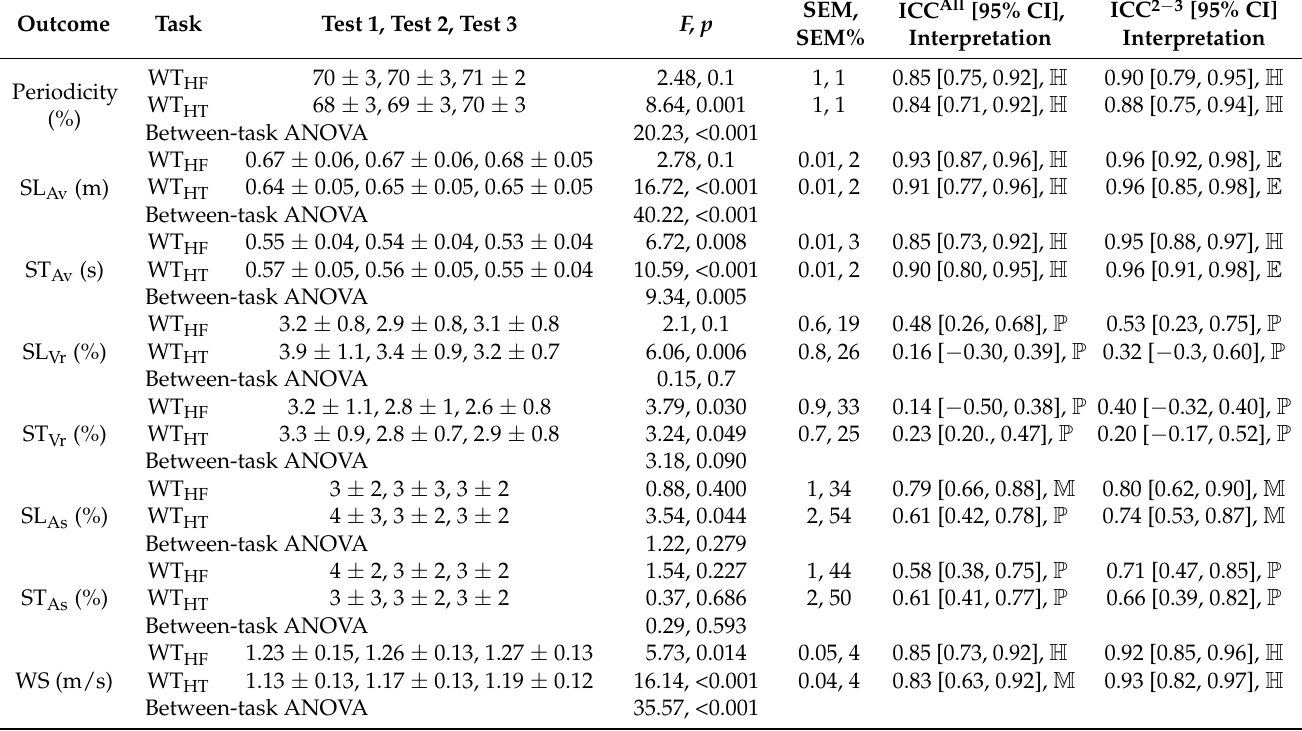
‘r p ’ = partial Pearson’s product–moment correlation coefficient; CI = confidence intervals; PS = postural stability (units: − ln[m/s/s]); PSML = postural stability in the mediolateral axis (units: − ln[m/s/s]); PSAP = postural stability in the anterior–posterior axis (units: − ln[m/s/s]). Table 4. Reliability, repetition effect, and between-task comparisons of the gait outcomes obtained from the Gait&Balance (G&B)